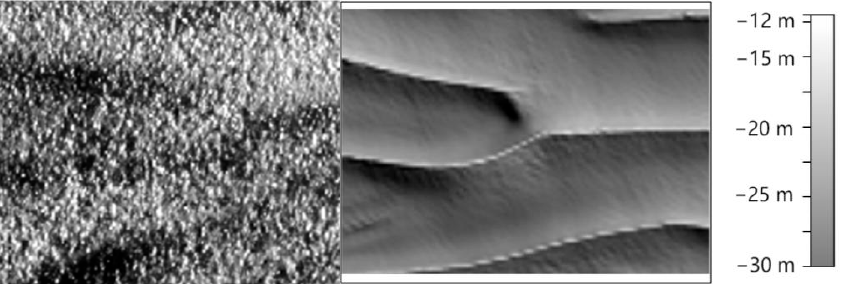
Figure 7. Original image of area b ( left ) and water depth inversion image ( right ).